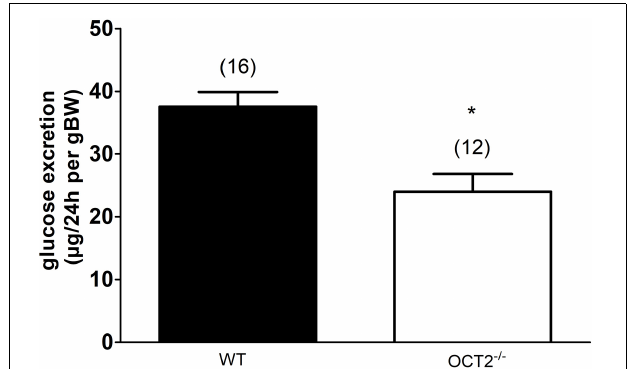
FIGURE 4 | Glucose excretion measured in urines from WT- and OCT2 − / − -mice. The mice were placed in a metabolic cage and urine was collected over 24 h. The glucose concentration is normalized according to the weight of the animal (body weight, BW). OCT2 − / − -mice excrete significantly less glucose than the WT animals (*, unpaired t -test). The numbers on the top of the columns indicate the number of mice used in the